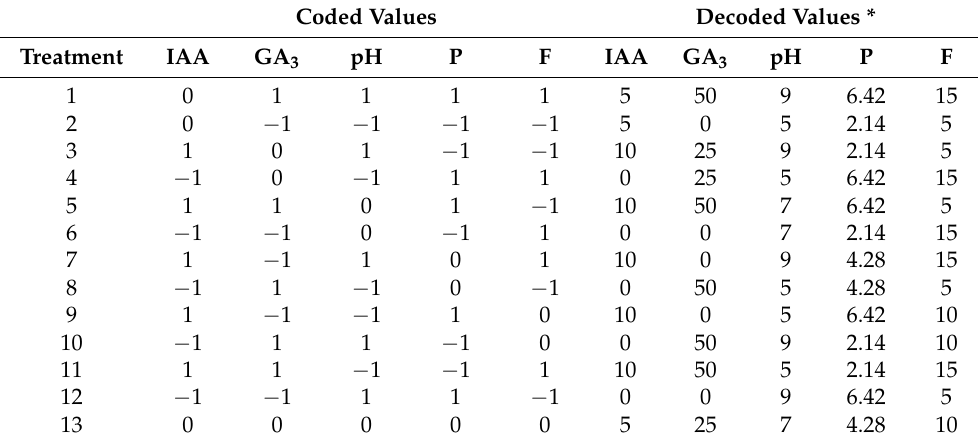
Table 2. Treatments generated for the definitive screening design